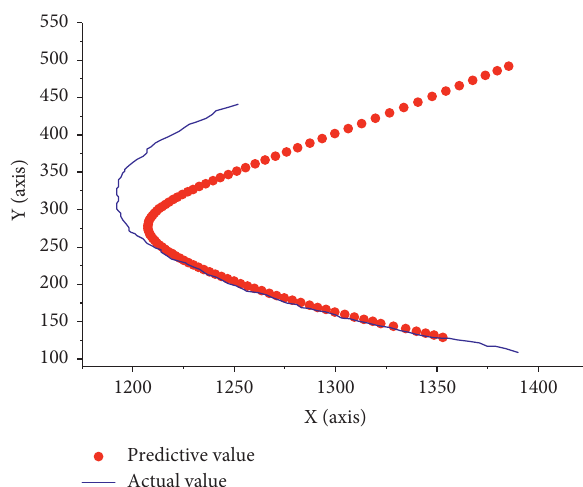
Figure 16: Prediction result of the left-turn trajectory.